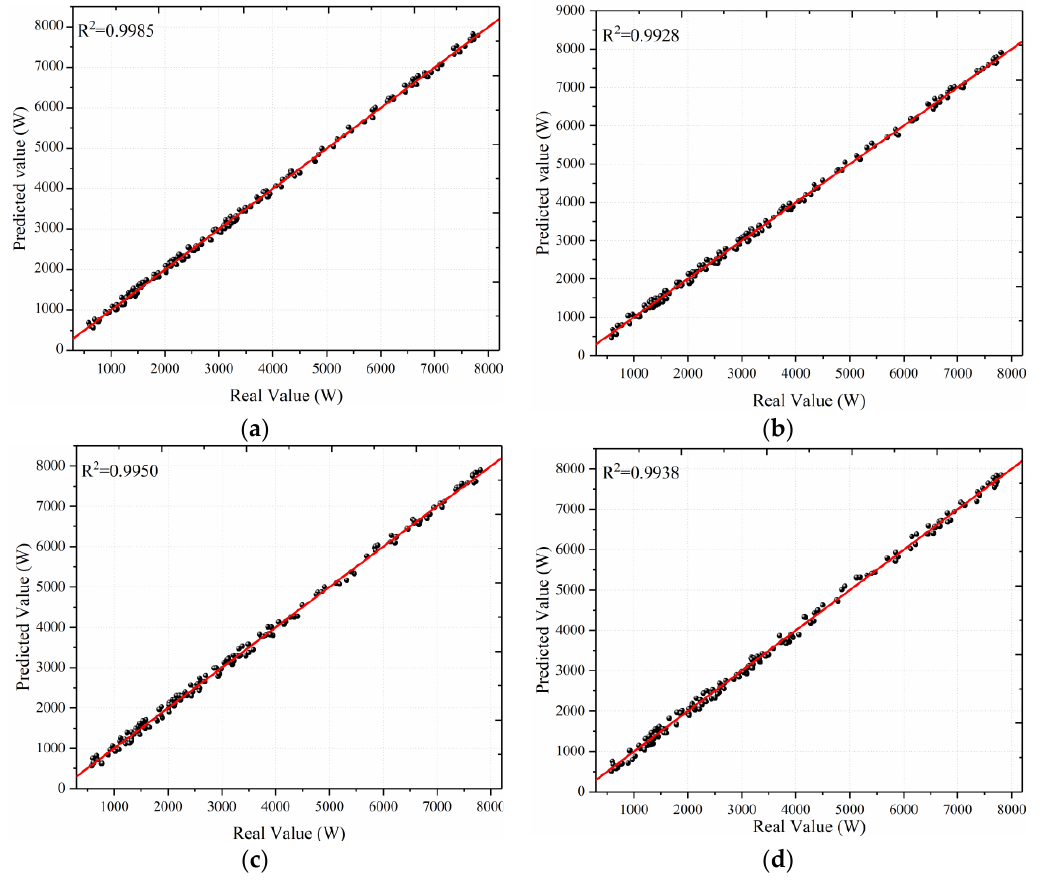
Figure 9. The scatter diagram of the different prediction model: ( a ) VMD-TCN; ( b ) VMD-LSTM; ( c ) TCN; ( d ) LSTM.